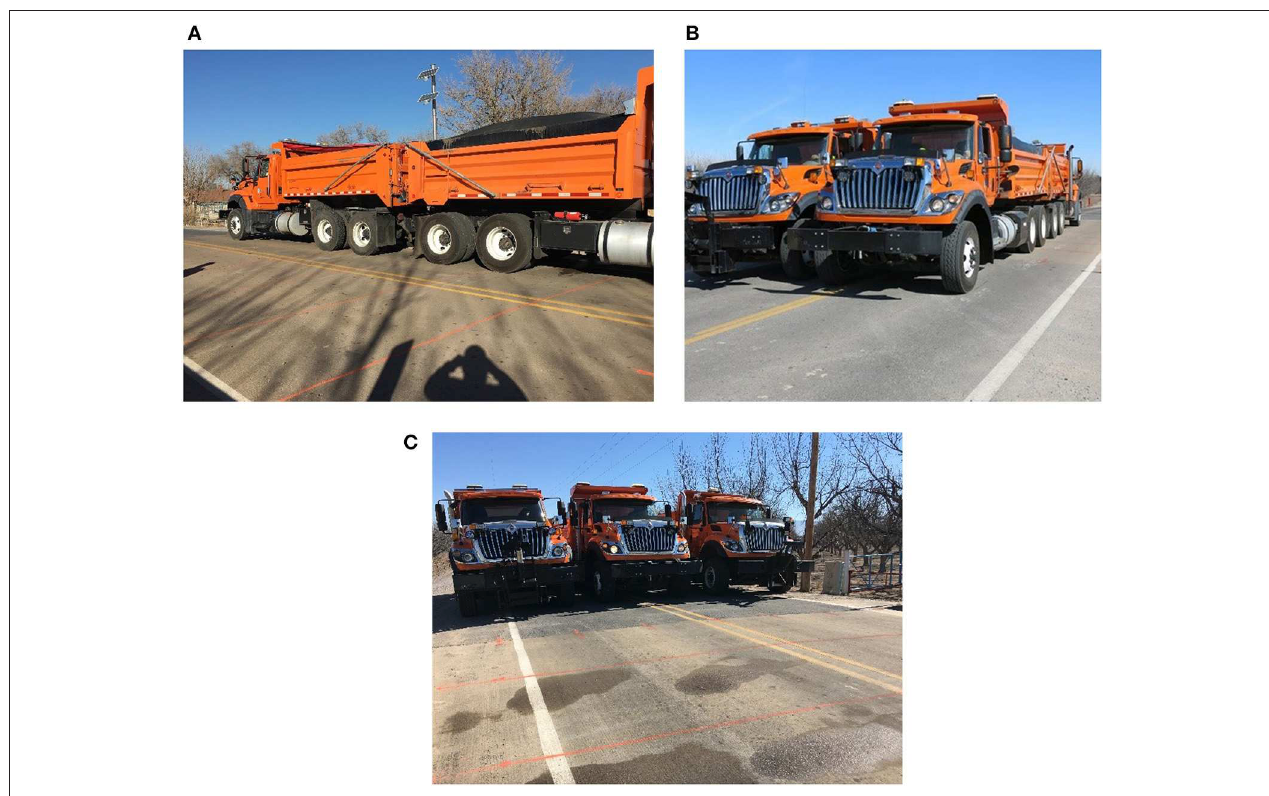
FIGURE 7 | (A) Single truck back-to-back loading, (B) double truck back-to-back loading, (C) triple truck side-by-side